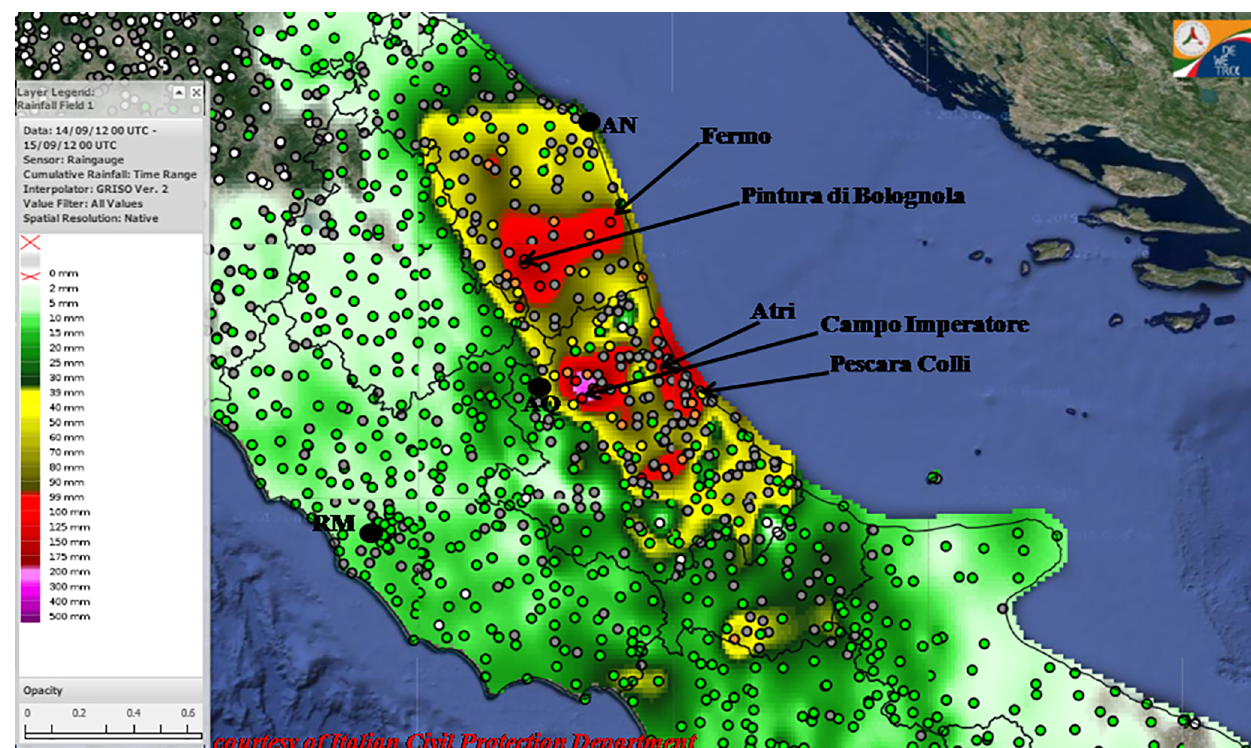
Figure 2. Interpolated map of 24h accumulated rainfall from 00:00UTC on 14 September 2012 over Abruzzo and Marche regions taken from the DEWETRA system from rain gauge measurements. Black contours are the administrative boundaries of regions, while the coloured circles represent the warning pluviometric